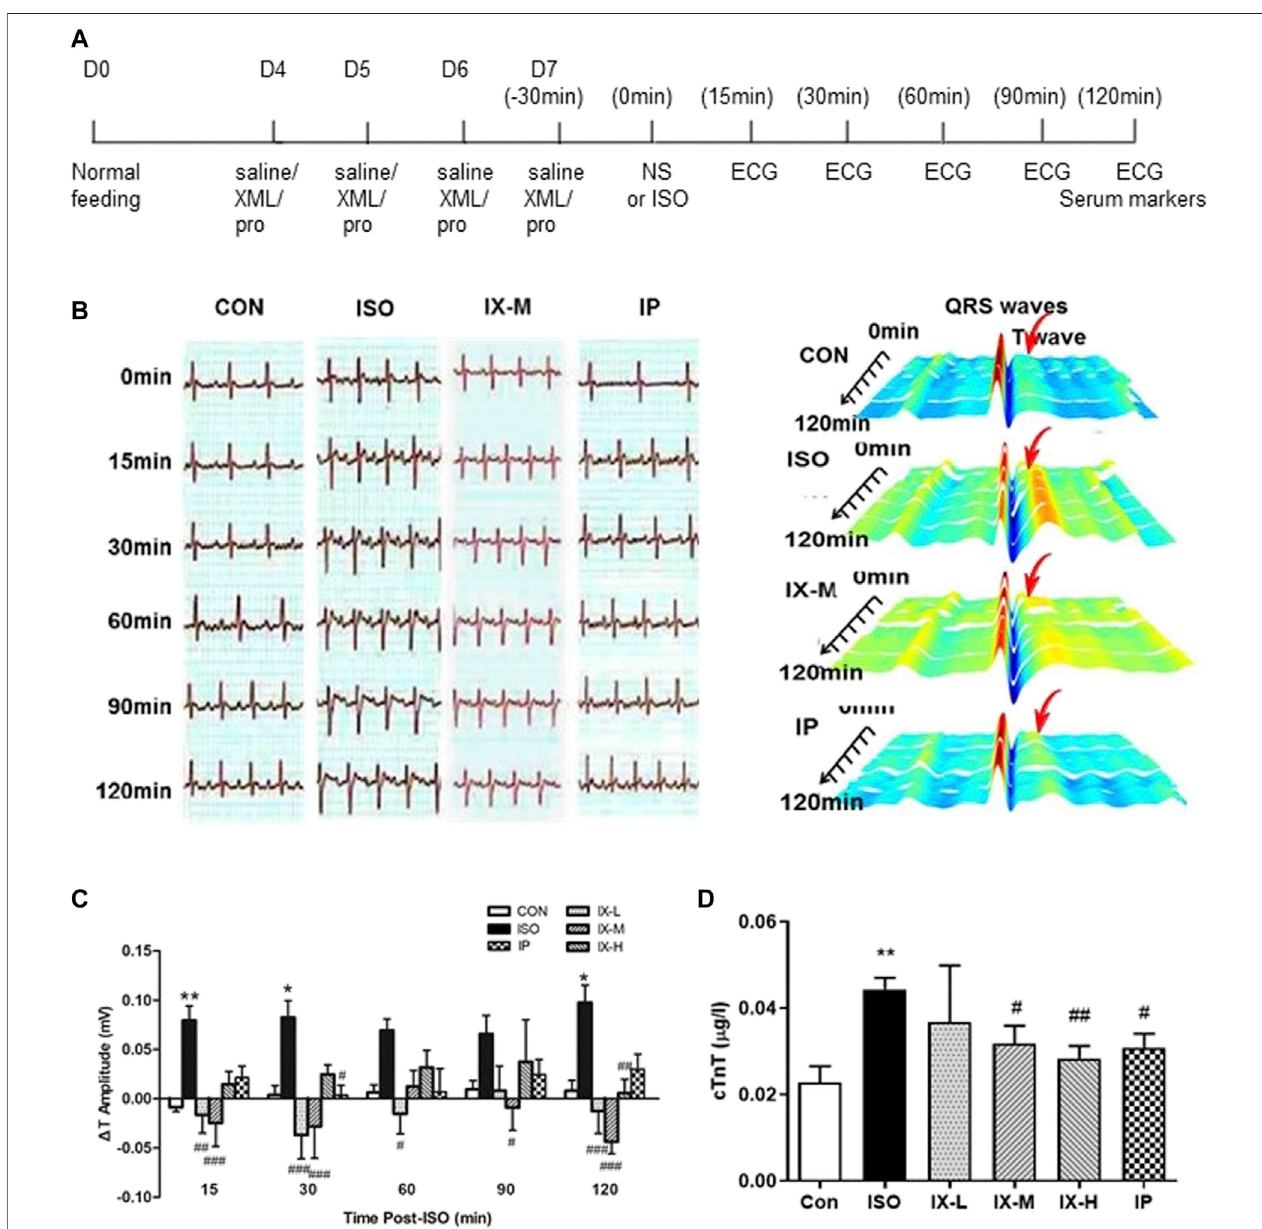
FIGURE1| ProtectiveeffectofXMLonisoproterenol-inducedmyocardialischemiainaratmodel. (A) Timelineofdrugadministration.CONrats( n =5)weretreated withnormalsaline,whiletestgroupsreceivedanXMLinjection(lowdose — L( n =5),mediumdose — M( n =6),highdose — H( n =5)),orpropranolol(10 mg/kg)( n =5)for a total of 4 days 30 min after the fi nal administration, rats were subcutaneously injected with isoproterenol (5 mg/kg) to induce the myocardial ischemia model. Heart contractile function was assessed using the noninvasive cardiac imaging technology of echocardiography (ECG) and by measuring the levels of the cardiac troponin T (cTnT) biomarker. (B) Electrocardiogram recordings of SD rats. (C) T interval of rats in each group. (D) cTnT levels for each group. Asterisk (*) refers to statistical signi fi cance in comparisons with the CON group (* p < 0.05, ** p < 0.01), while # refers to comparisons with the ISO group ( # p < 0.05, ## p < 0.01, ### p < 0.005).